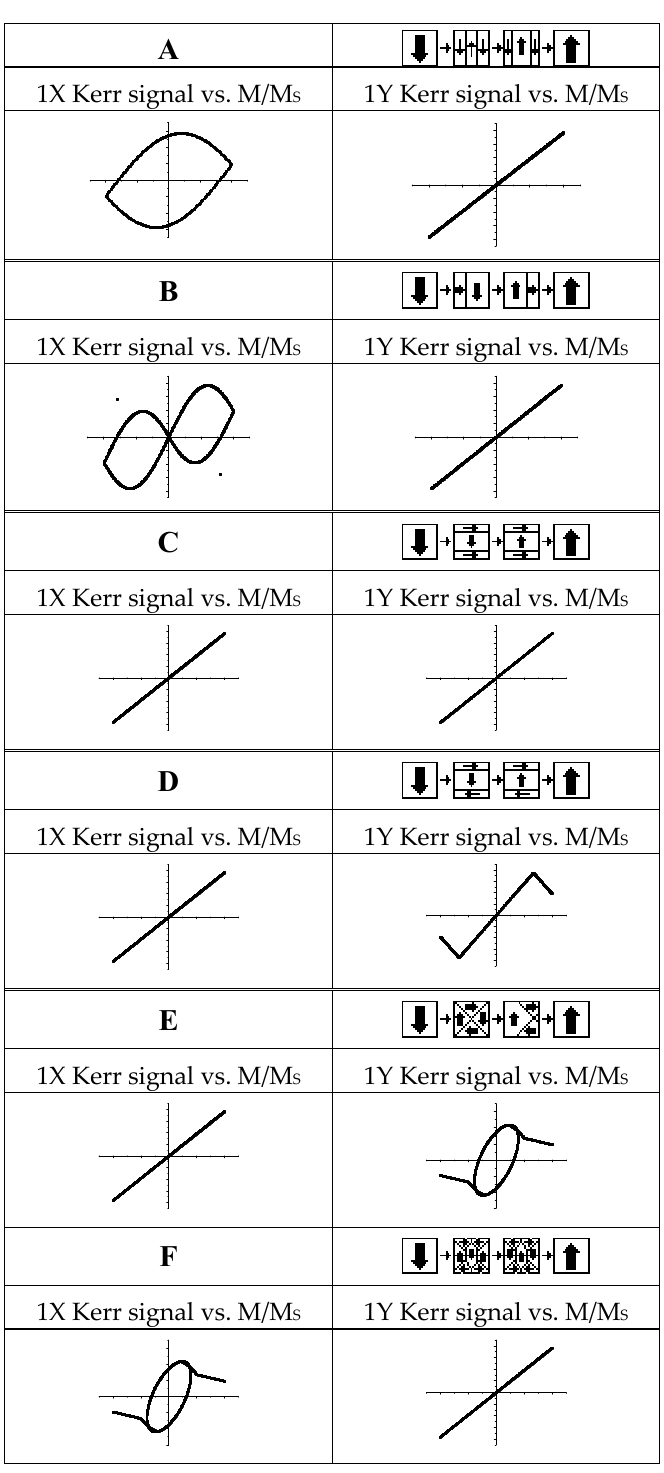
Figure 2. Diffracted signal 1X (left) and 1Y (right) vs. magnetisation for different inversion processes: Figure 2. Di ff racted signal 1X (left) and 1Y (right) vs. magnetization for di ff erent inversion processes: ( A ) Propagation of two 180° domain wall parallel to the applied field. ( B ) Two consecutive ( A ) Propagation of two 180 ◦ domain wall parallel to the applied field. ( B ) Two consecutive propagations propagations of a single 90° domain wall. ( C ) S state with domain walls situated at 1/6 square length of a single 90 ◦ domain wall. ( C ) S state with domain walls situated at 1 / 6 square length of the edge. of the edge. ( D ) C state with domain walls situated at 1/6 square length of the edge. ( E ) Vortex ( D ) C state with domain walls situated at 1 / 6 square length of the edge. ( E ) Vortex displacement along displacement along X axis (the so-called Landau domain structure). ( F ) Seven domains structure. X axis (the so-called Landau domain structure). ( F ) Seven domains